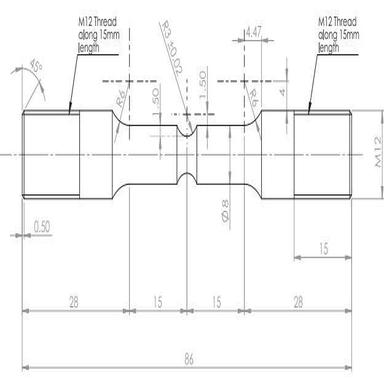
RNB6 specimen geometry (a = 5 mm, ρ = 3 mm).